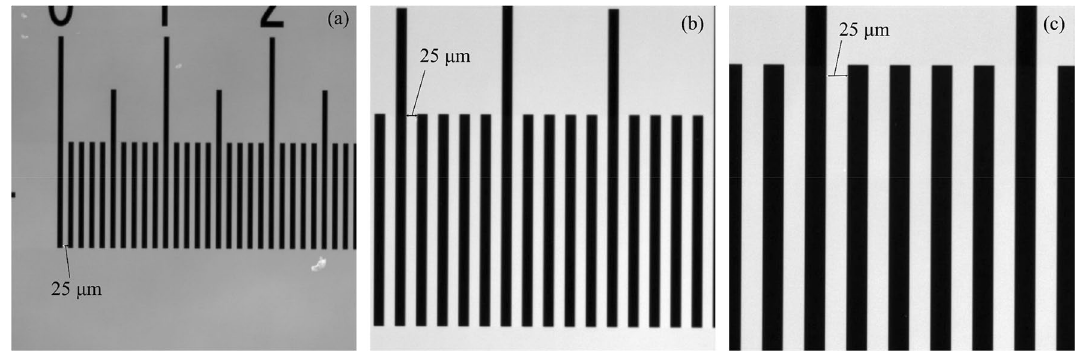
Figure 1. Optical images of the calibration sample at zoom ranges of ( a ) 5 ×, ( b ) 10× , and ( c ) 20 ×. The slit width is 25 µm. Zoom Resolution (distance/pixel) Field of